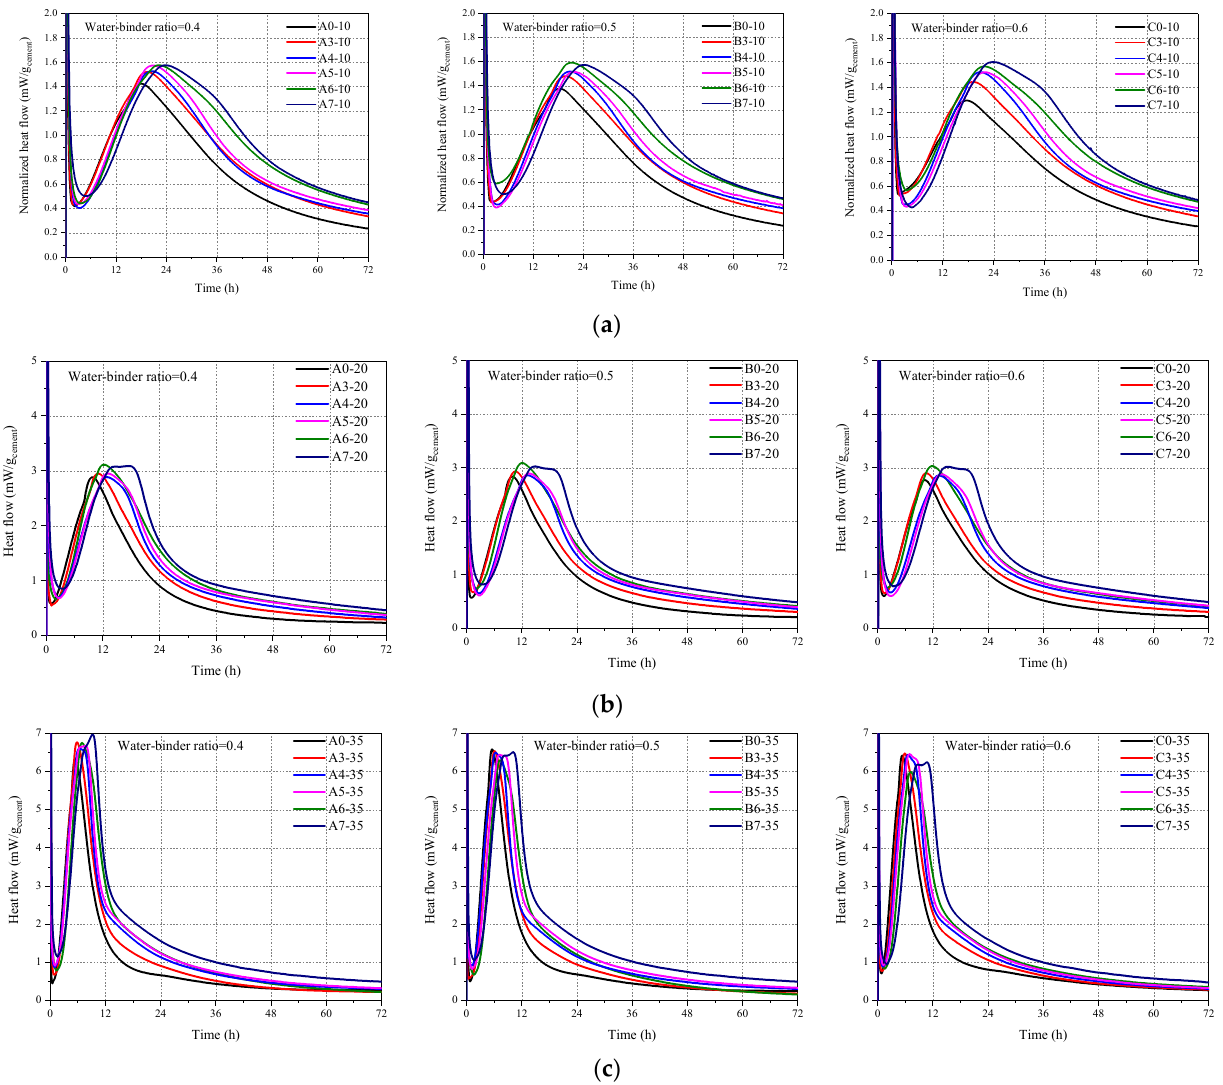
Figure 6. Heat flow of the paste at different temperatures (normalized to cement). ( a ) heat flow of the paste at 10 °C; ( b ) heat flow of the paste at 20 °C; ( c ) heat flow of the paste at 35 °C